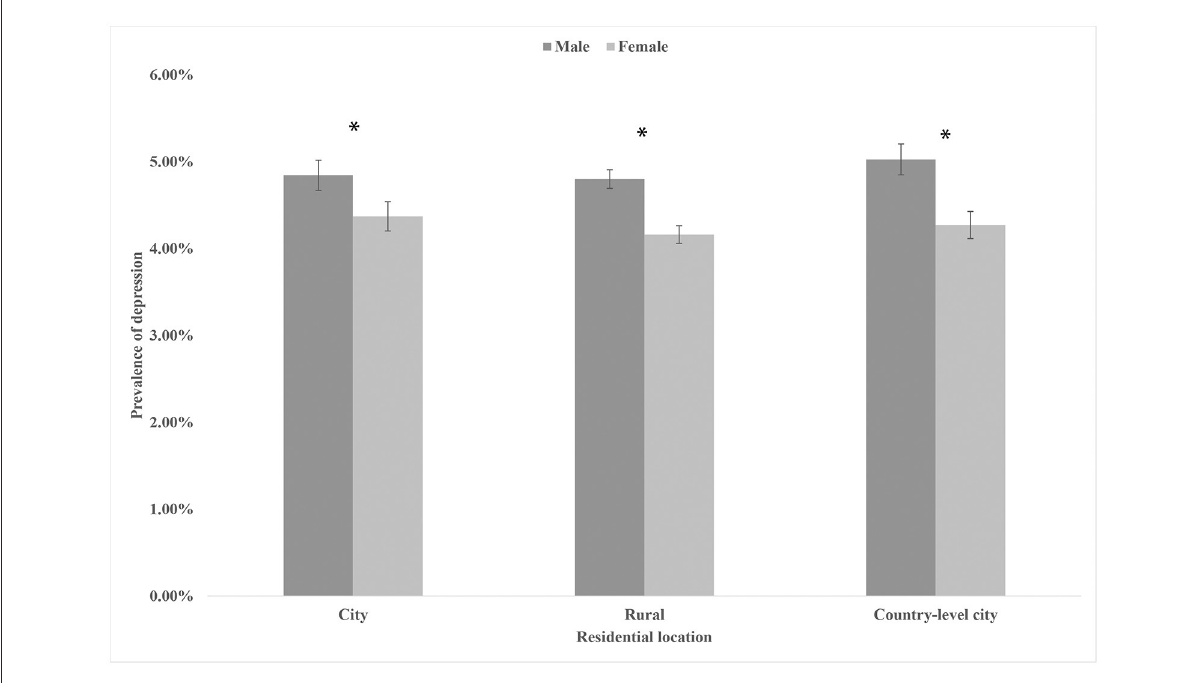
FIGURE1 The prevalence of depression symptoms in participants by residential location and gender. * P < 0.05.